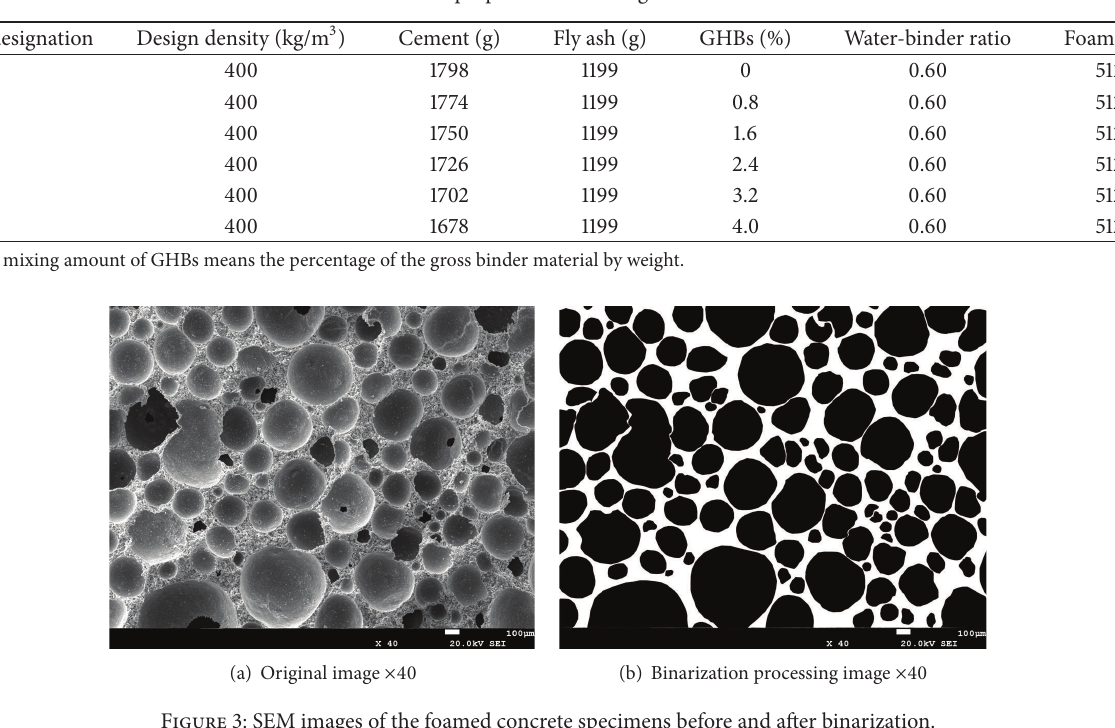
Table 2: Mix proportions of 400 kg/m 3 GHBFC.